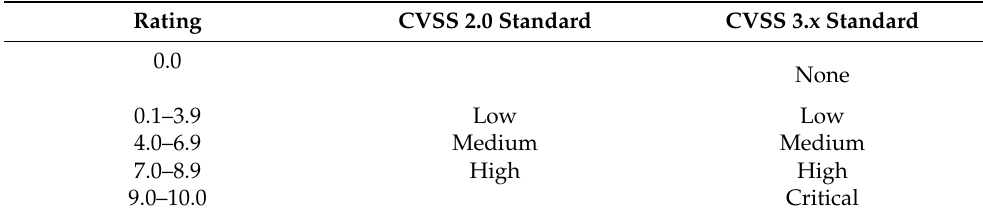
Table 2. Differences in vulnerability categories for CVSS 2.0 and CVSS